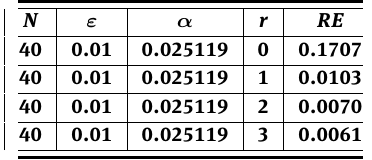
Table 2. The absolute errors Era for fixed α and for various value of